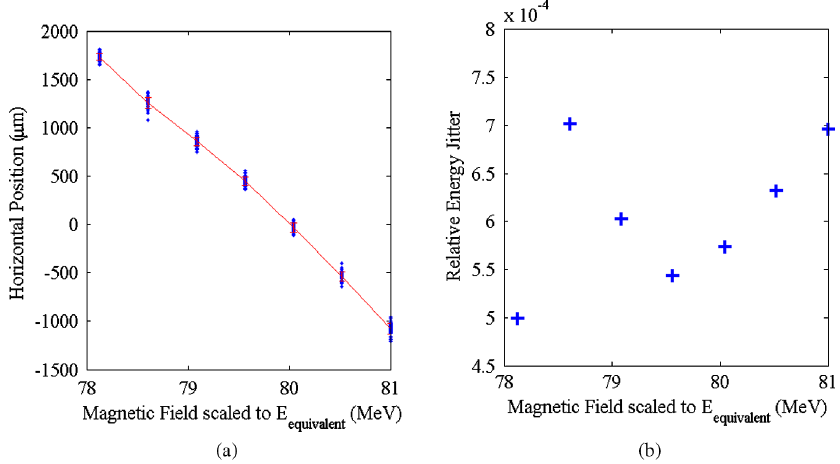
FIG. 34. Energy stability measured from the beam centroid jitter on the spectrometer screen: (a) 50 samples for each spectrometer magnet setting and (b) energy jitter relative to the nominal 80 MeV beam